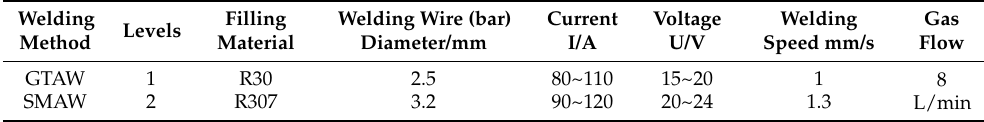
Table 1. Welding methods and